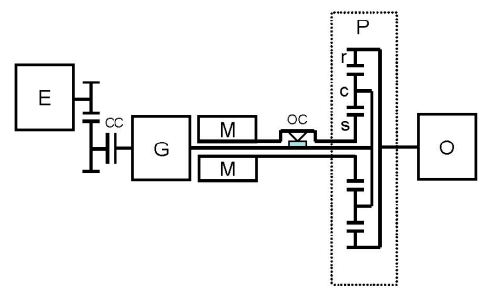
Figure 7. Schematic powertrain architecture of planetary gearset and dual clutch (PDC) in the electric circulation mode.